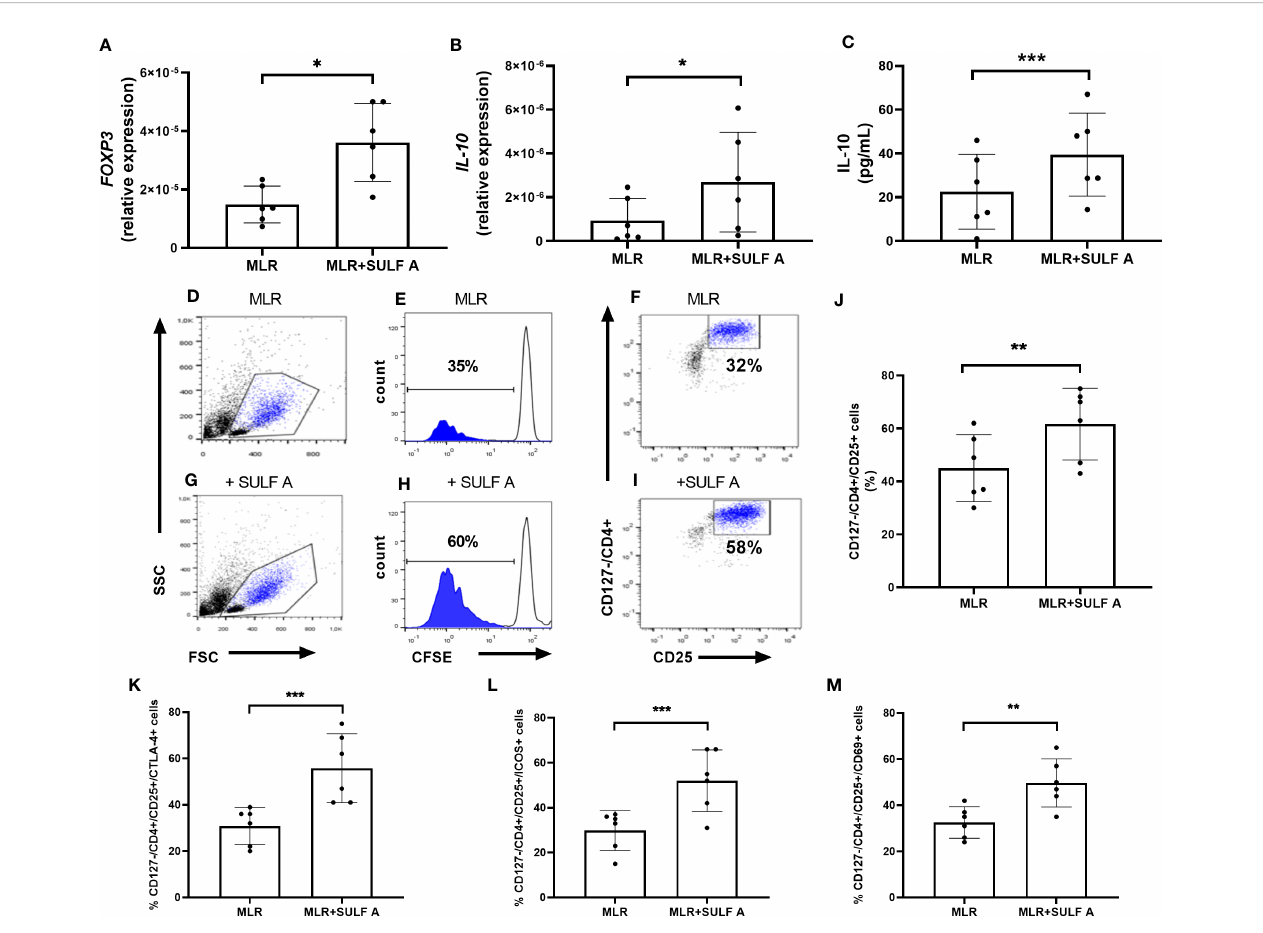
FIGURE 4 SULF A-dependent expansion of T cells in the allogeneic MLR experiment. RNA Expression of FOXP3 (A) and IL-10 (B) measured by qPCR. Results were normalized to 18S mRNA and analyzed by D Ct method. Values on y-axis represent the relative expression of mRNA levels compared to control. (C) IL-10 concentration in the MLR supernatants measured by ELISA assay. (D – I) Representative fl ow cytometry analysis of proliferating and CFSE-negative populations corresponding to the CD127-/CD4+/CD25+ subset. Analysis gated 5000 live cells. (J) SULF A-dependent expansion of CD127-/CD4+/CD25 + T cells (mean ± s.d) on 6 different experiments. The analysis was carried out acquiring 5000 live cells according to the gate strategy reported in Supplementary Figure 5; (K-M) Levels of cells positive for CTLA-4, ICOS and CD69 measured by fl ow cytomtery within